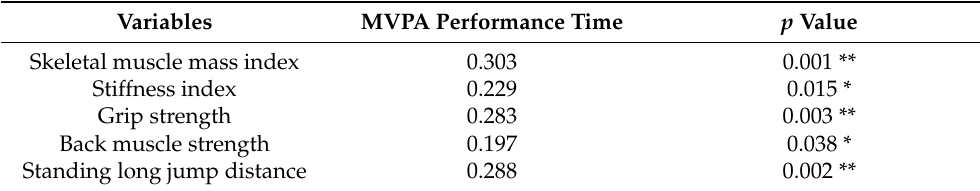
Table 2. Factors associated with time of performing moderate to vigorous physical activity among the all participants ( n = 111) a .